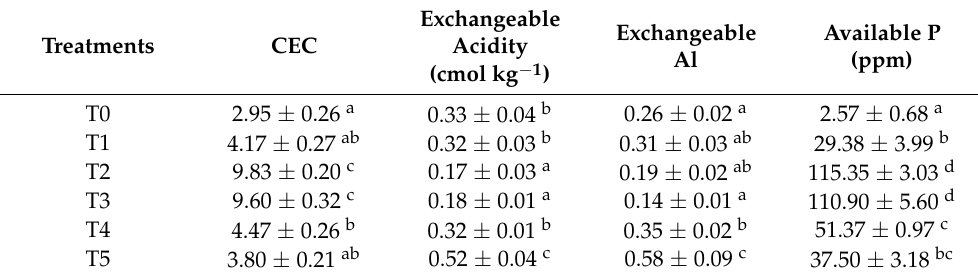
Table 8. Effects of RSRH biochar on soil CEC, exchangeable acidity, exchangeable Al, and available P at harvest (70 DAT).